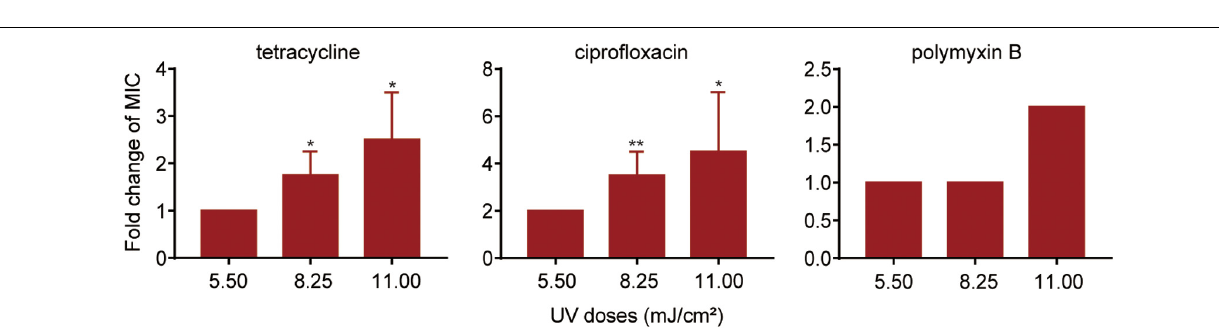
FIGURE 2 | Fold changes in MICs of antibiotics against P. aeruginosa surviving UV irradiation, relative to the untreated controls. MIC assays of tetracycline, ciprofloxacin and polymyxin B were performed using the broth microdilution method in accordance with the Clinical and Laboratory Standards Institute guidelines. Data are shown as the mean ± standard deviation (s.d.). ( n = 4). * P < 0.05 and ** P < 0.01; assessed by Student’s t